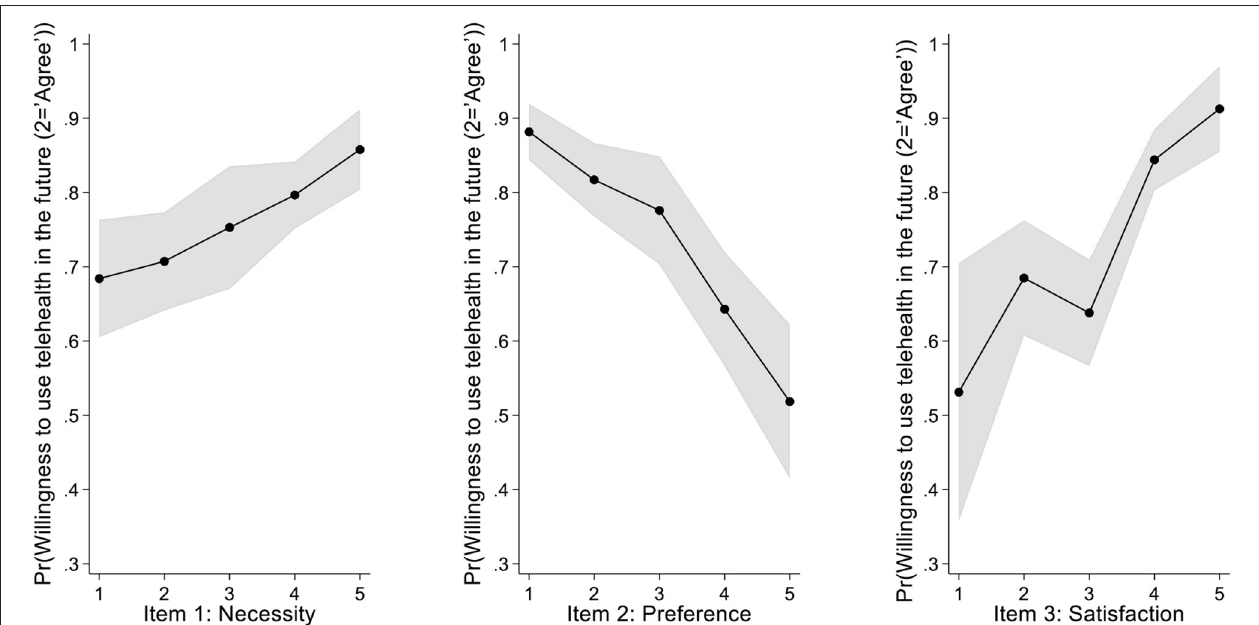
FIGURE 1 | Average Adjusted Predictions for Items 1 to 3. The y -axis represents the likelihood of agreeing with the statement “I will continue to use telemedicine in the future”; shaded gray represents 95% CI. Post-hoc analysis reveals a linear trend relating to the correlation between a given item and the likelihood of agreeing with the statement. Specifically, we found a linear trend for Item 1 ( χ 2 1 = 16.54, p < 0.001; contrast = 0.060; 95% CI: 0.031, 0.089), for Item 2 ( χ 2 1 = 44.36, p < 0.001; contrast = − 0.113; 95% CI: − 0.142, − 0.084), and for Item 3 ( χ 2 1 = 16.54, p < 0.001; contrast = 0.104; 95% CI: 0.073, 0.134). Consistent with the correlation analysis, we found an association between each item and the intent to use telemedicine in the